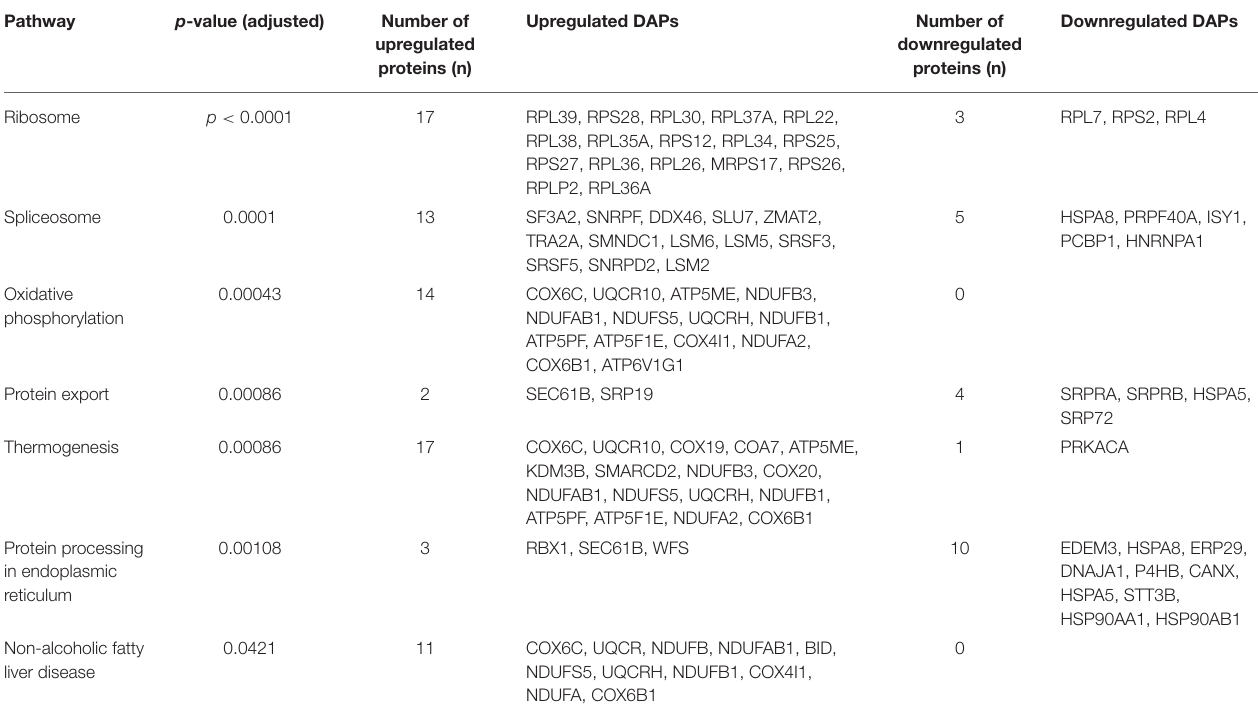
Downregulated DAPs downregulated proteins (n)